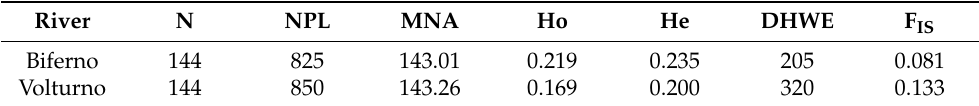
Table 1. Genetic diversity for two trout population from Molise rivers. N—number of individuals, NPL—number of polymorphic loci, MNA—mean number of alleles, Ho observed heterozygosity, He—expected heterozygosity, DHWE—loci with deviation from H–W equilibrium and population specific F IS .